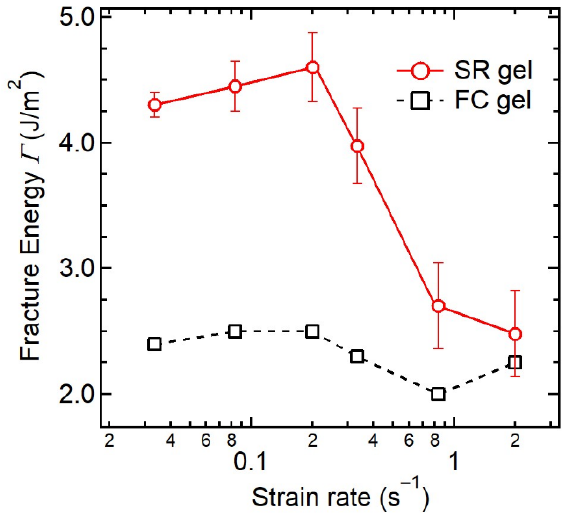
Figure 15. Strain rate dependence of fracture energy for FC and SR gels. Reprinted from [31] with permission from Elsevier.